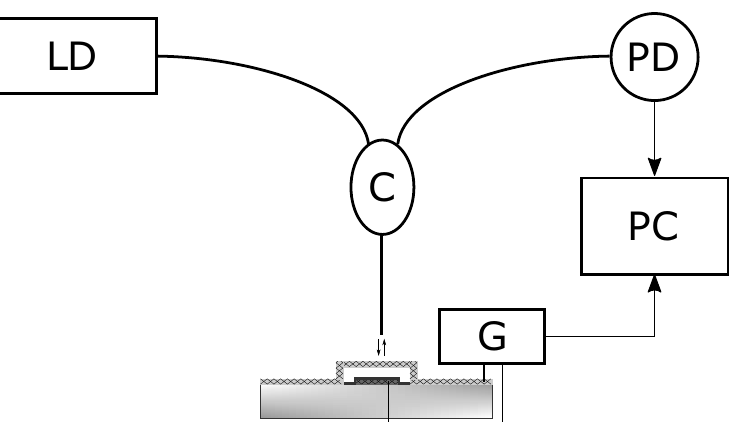
Figure 9. Schematic diagram for frequency response measurement. LD-laser diode, C-optical circulator, PD-photodetector, G-sound generator, PC-personal computer.